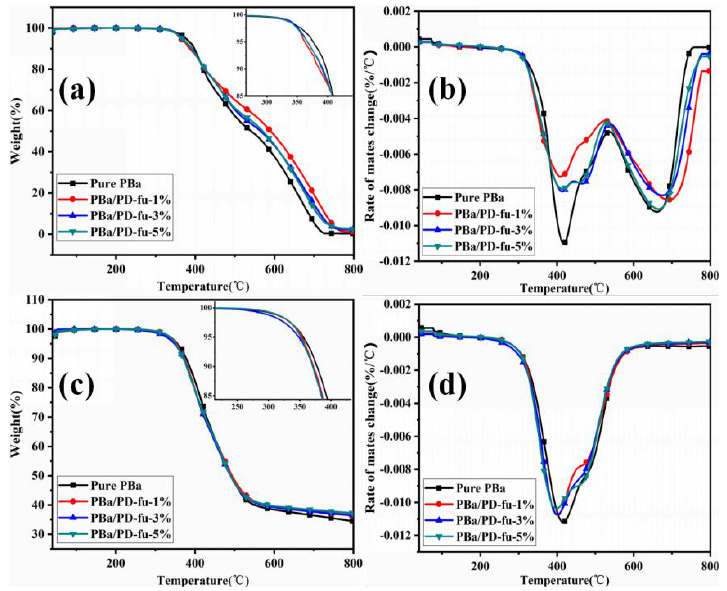
Figure 6. ( a , c ) TGA and ( b , d ) DTG curves for PBa and PBa/PD-fu composites in air and N 2 atmospheres. Table 2. The TGA results for PBa and composites in air and N 2.